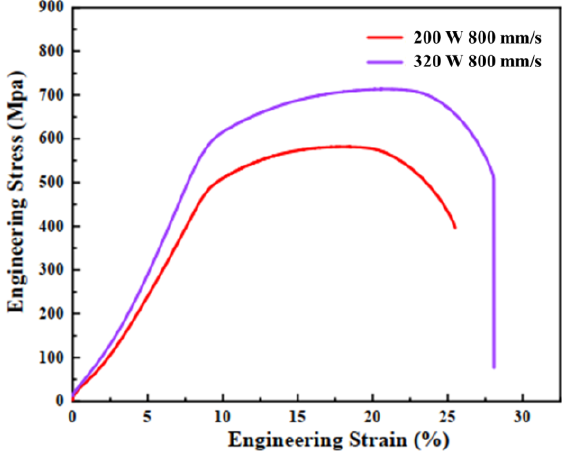
Figure 8. Stress – strain curves of the SLMed CLF-1